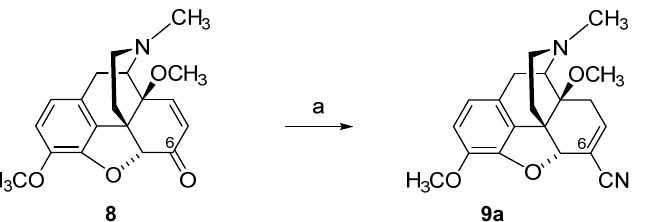
Scheme 4. Synthetic route to compound 8a . Reagents and conditions: ( a ) Compound 8 was added min, then CH 3 I was added.